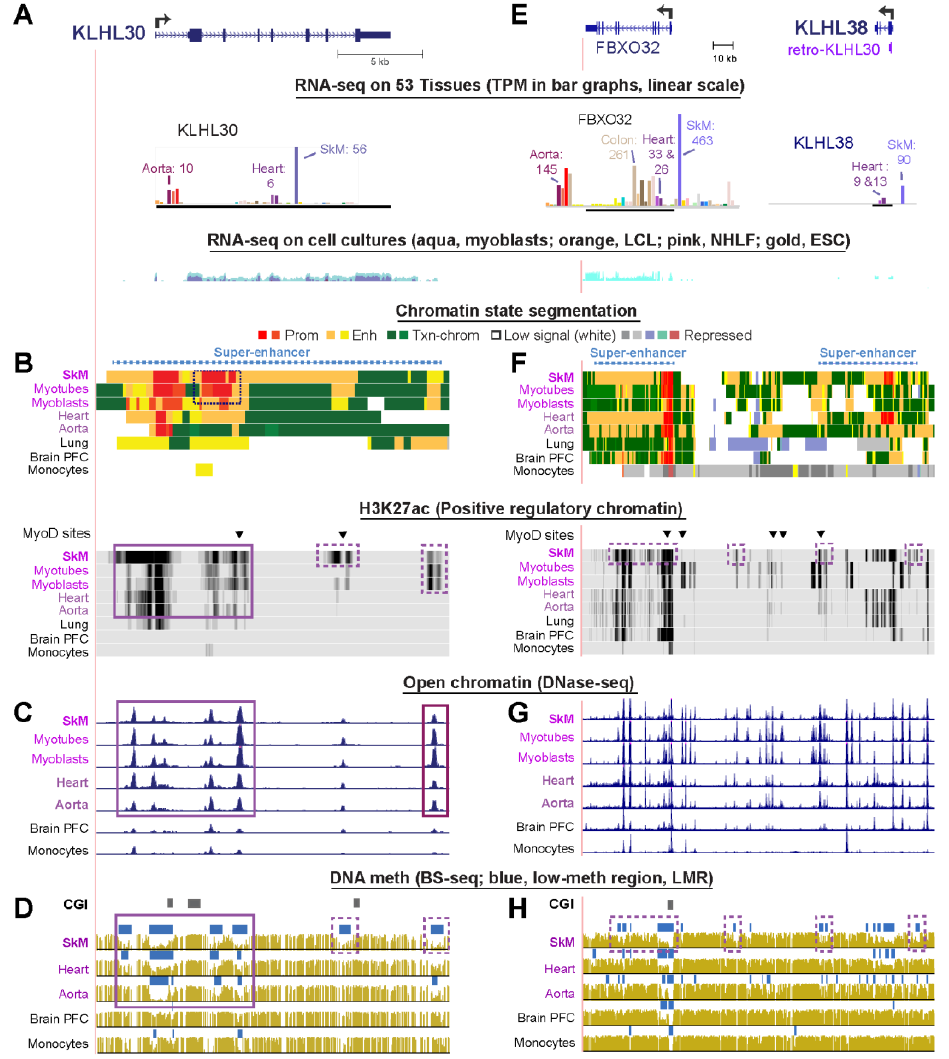
Figure 2. KLHL30 and KLHL38 , little studied KLHL genes, have super-enhancer chromatin and DNA hypomethylation that can drive their high, muscle-specific expression. ( A – D ) KLHL30 (chr2:239,043,816-239,065,093) and ( E – H ) KLHL38 and its downstream neighbor, FBXO32 (chr8:124,508, 193-124,686,846). Tracks from UCSC Genome Browser are as described in Figure 1. The immediate upstream neighbor of KLHL38 , FBXO32 / Atrogen-1, a gene encoding an E3-ubiquitin ligase, is implicated in muscle atrophy [37]. Boxed regions are tissue-specific epigenetic marks described in the text; triangles, sites where MyoD is